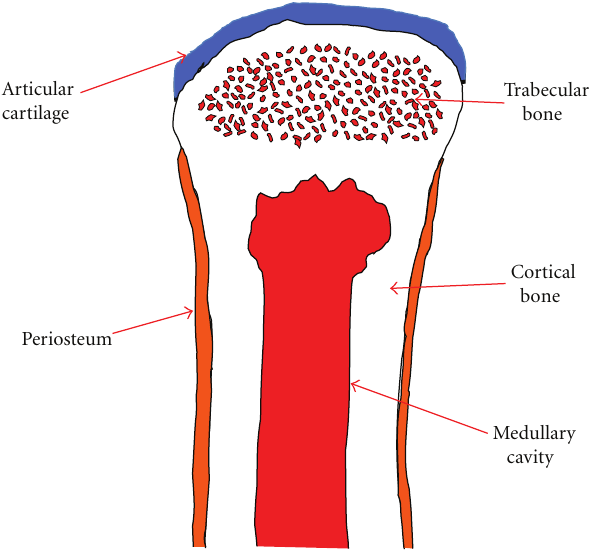
Figure 1: Schematic diagram of a portion of a long bone showing the articular cartilage, trabecular bone, cortical bone, medullary cavity, and periosteum.